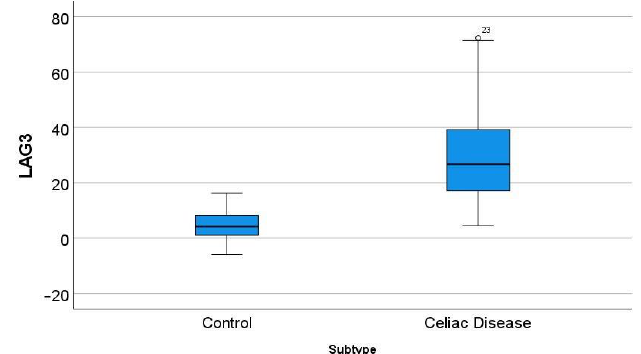
Figure 9. Differential gene expression of LAG3 between celiac disease and control in the series GSE164883. A direct comparison was statistically significant: 30.7 ± 17.9 vs. 4.6 ± 4.9 ( p < 0.001). The outliers are marked with a circle, next to the icon there is a number that corresponds to the case number.